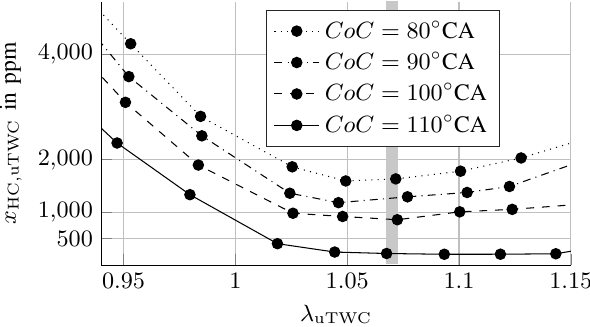
Figure 5. Hydrocarbon emission concentration x HC measured upstream of the catalyst when the air-to-fuel ratio in steady-state operating conditions is varied. The fixed set point for all cold-start measurements is defined as λ uTWC = 1.07, indicated in